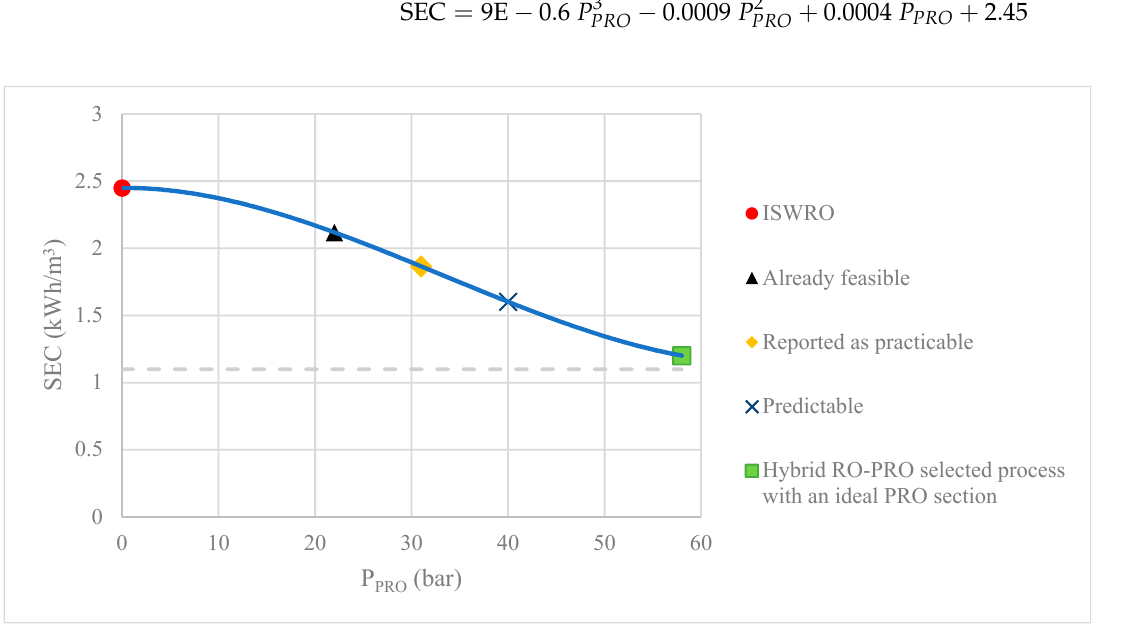
Figure 8. SEC behaviour of the selected hybrid RO-PRO desalination process as a function of the operating pressure of PRO. The dashed line represents the theoretical energy required for desalting seawater with an average TDS of 3.5